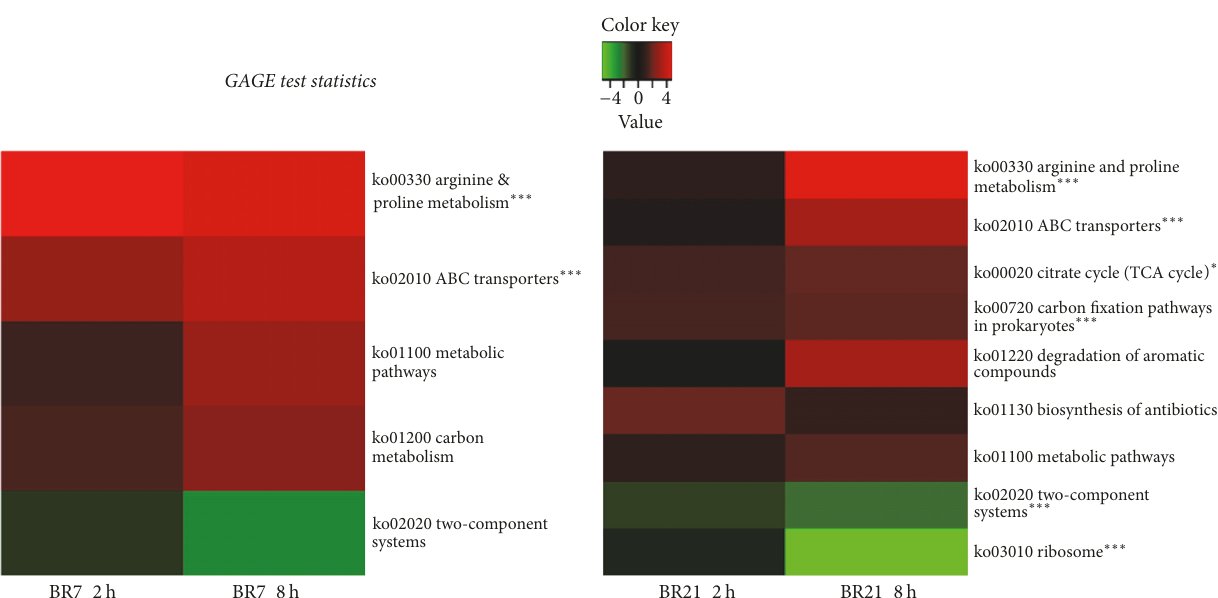
Figure 2: Significantly enriched KEGG orthology (KO) pathways after 2h and 8h of imipenem exposure followed by growth in drug-free broth medium. Generally applicable gene-set enrichment (GAGE) analysis shows log 2 fold change (FC) ratios from low (green) to high (red) expression in significantly enriched KO pathways for imipenem-exposed compared to unexposed bacterial populations (three biological replicates in each sample group). A false discovery rate 𝑞 -value cutoff ≤ 0.2 was applied. ∗∗∗ KO pathways with 𝑞 -value of <